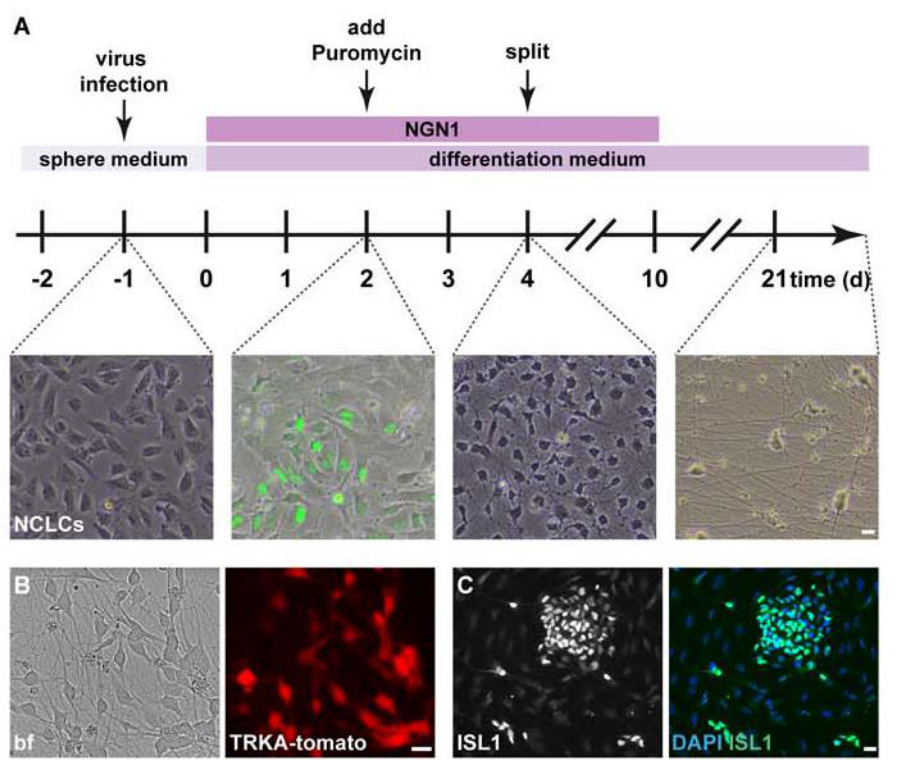
Figure 1. ( A ) Schematic illustration of the differentiation protocol to generate hESC–derived nociceptor–like cells: arrows indicate time points of virus infection, selection (addition of puromycin) and splitting of cells. Graphs show characteristic morphology of cells at the indicated time points: –1 day (d) neural crest–like cells (NCLCs), 2 d NGN1 expression, indicated by GFP–signal; 4d neural progenitors show small neurites; ≥ 21d neurons with long processes can be observed. ( B ) Live cell imaging of neuronal progenitors derived from the hESC TRKA–tomato reporter cell line: left picture shows a bright field ( bf ) image, right picture the tomato signal of cells 6 days after doxycycline–induced expression of NGN1. ( C ) Immunostaining of hESC–derived NCLCs 2 days after induction of NGN1–expression. As early as 2 days after NGN1 induction, the presence of the pan–sensory marker ISLET1 (ISL1) is detectable in a subset of cells. (DAPI: blue; ISL1: green). Scale bars: 20 µ